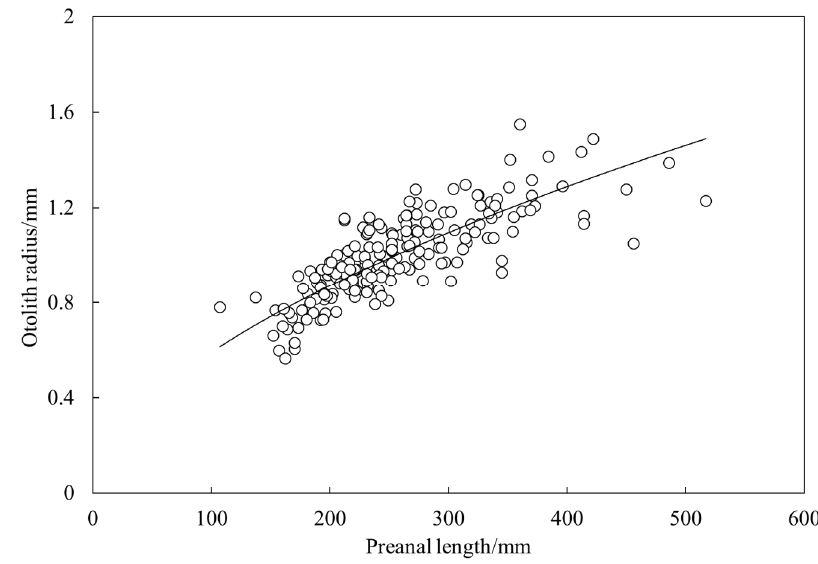
Figure 4. Relationship between preanal lengths and otolith radius of largehead hairtail Trichiurus japonicus .